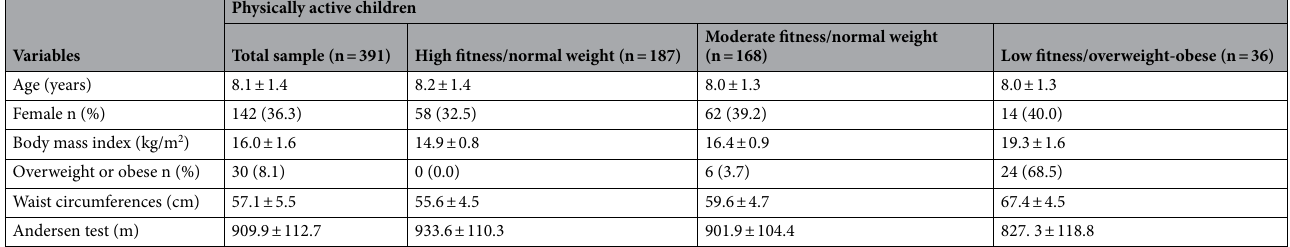
Table 1. Descriptive baseline data stratified by health trajectory group. Data are presented as mean ± SD for continuous variables or n (%) for categorical